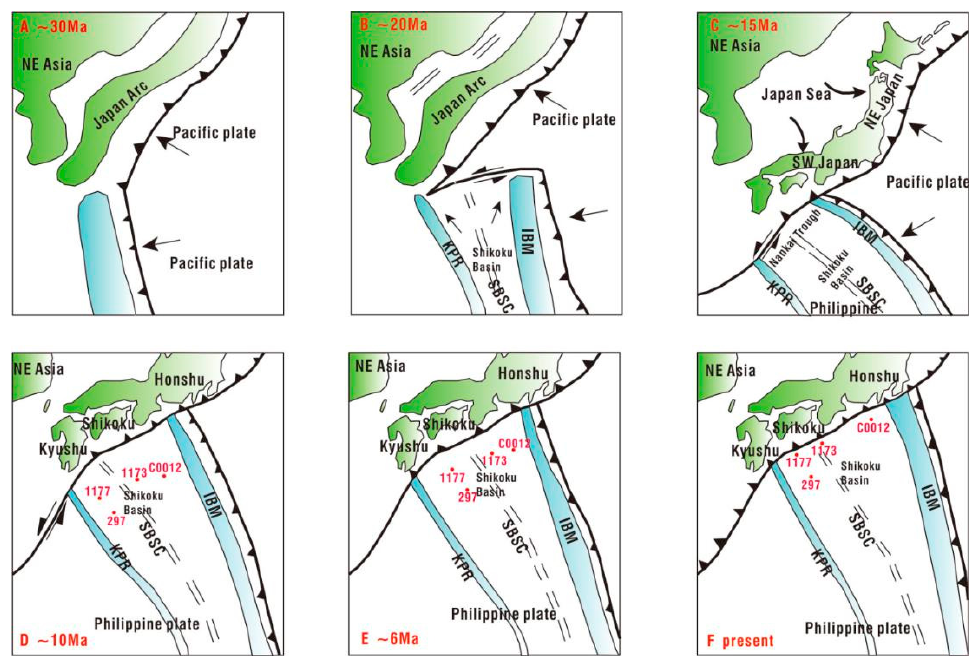
Figure 1. A schematic tectonic evolution model for the formation of the Shikoku Basin from 30 Ma to present. ( A – C ) are modified from Reference [1], ( D – F ) are modified from Reference [4]. Abbreviation: KPR, Kyushu-Palau Ridge; IBM, Izu-Bonin-Mariana arc; SBSC, Shikoku Basin Spreading Center. The numbers indicate the Integrated Ocean Drilling Program (IODP) drilling sites, and 1173 and C0012 are the two sites studied in this paper.